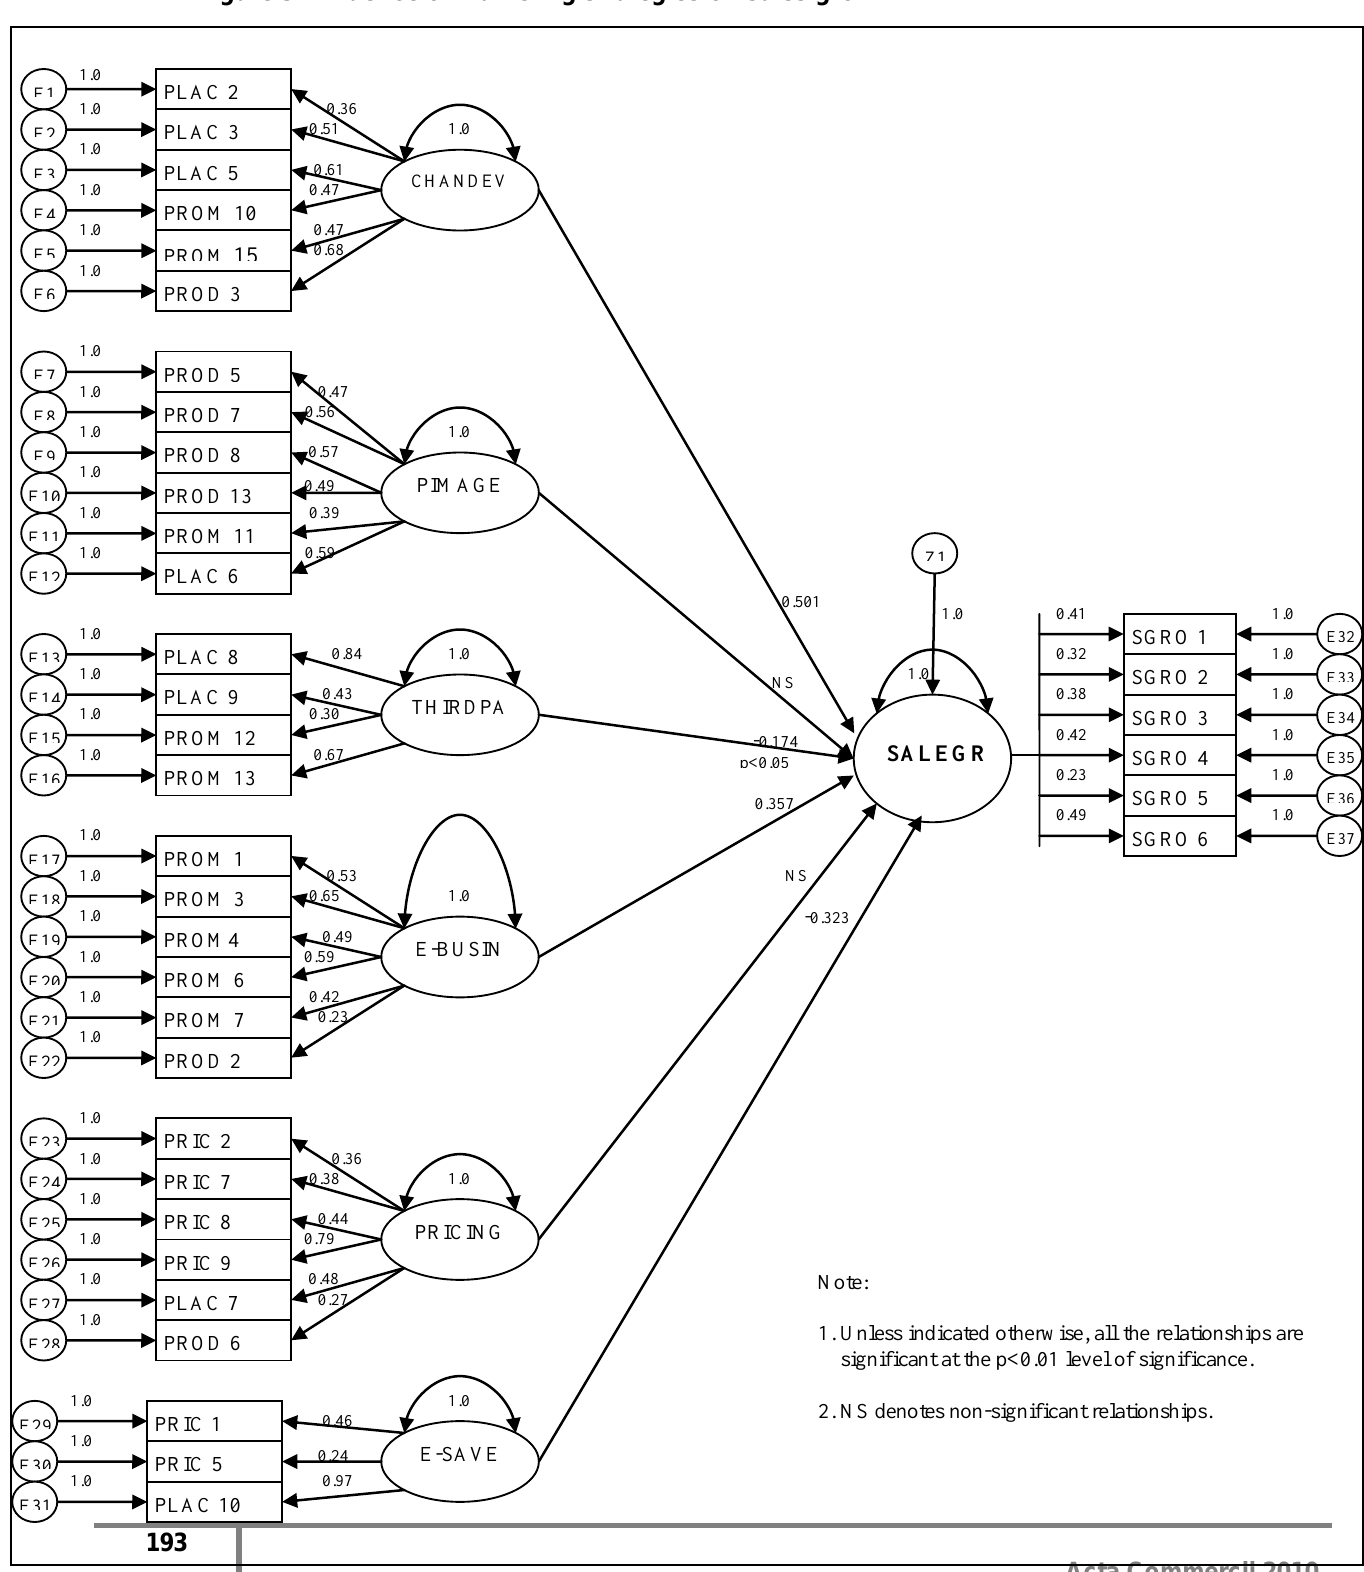
Figure 3: influence of marketing strategies on sales